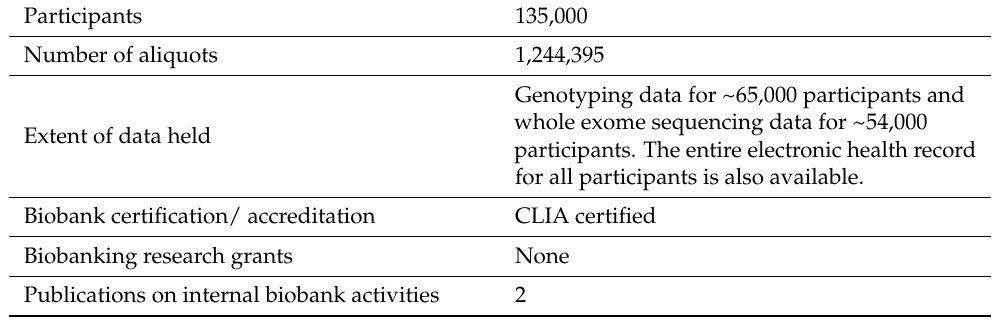
Table 4. Internal metrics.